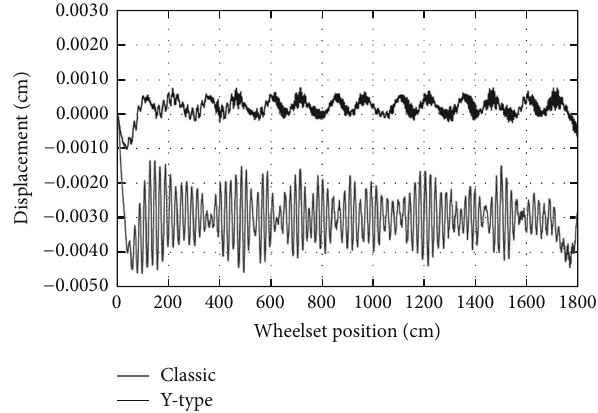
Figure 16: Vertical displacements of rails registered 180cm in front of the contact points of the buggy for classic and “Y” - type track at the speed 40 m/s